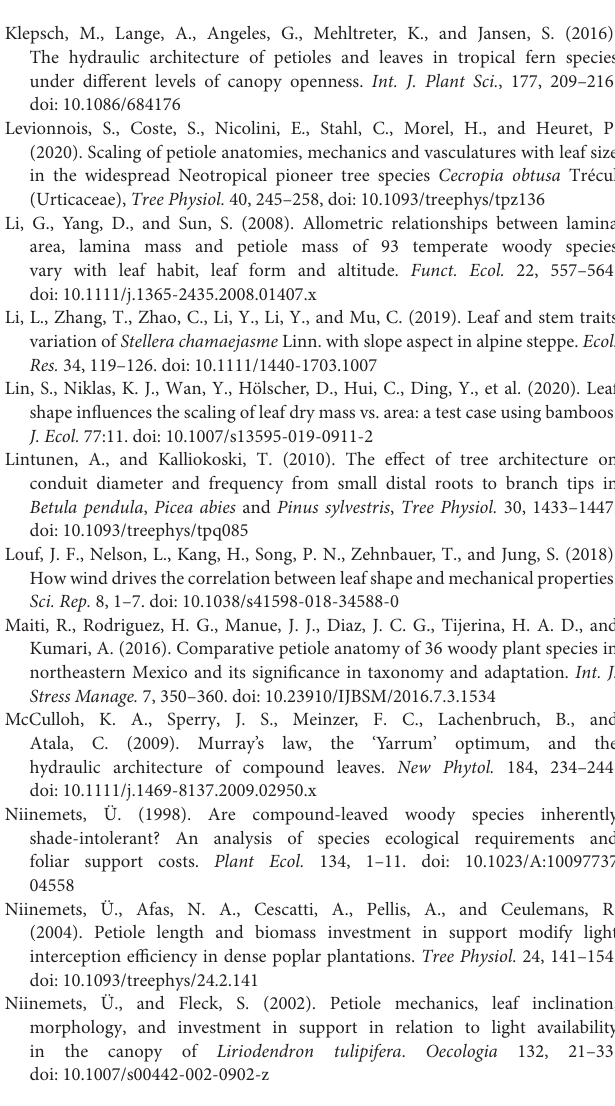
Abbreviations of leaf traits were as specified in Figure 2 . Supplementary Figure 2 | Effect size and 95% confidence intervals of the PL–R Supplementary Table 1 | Mean ± standard error of six petiole and lamina traits for 15 altitudinal transects. Supplementary Data | A comparison of six petiole and lamina traits for 325 woody species (537 populations). PL, petiole length (cm); LL, lamina length